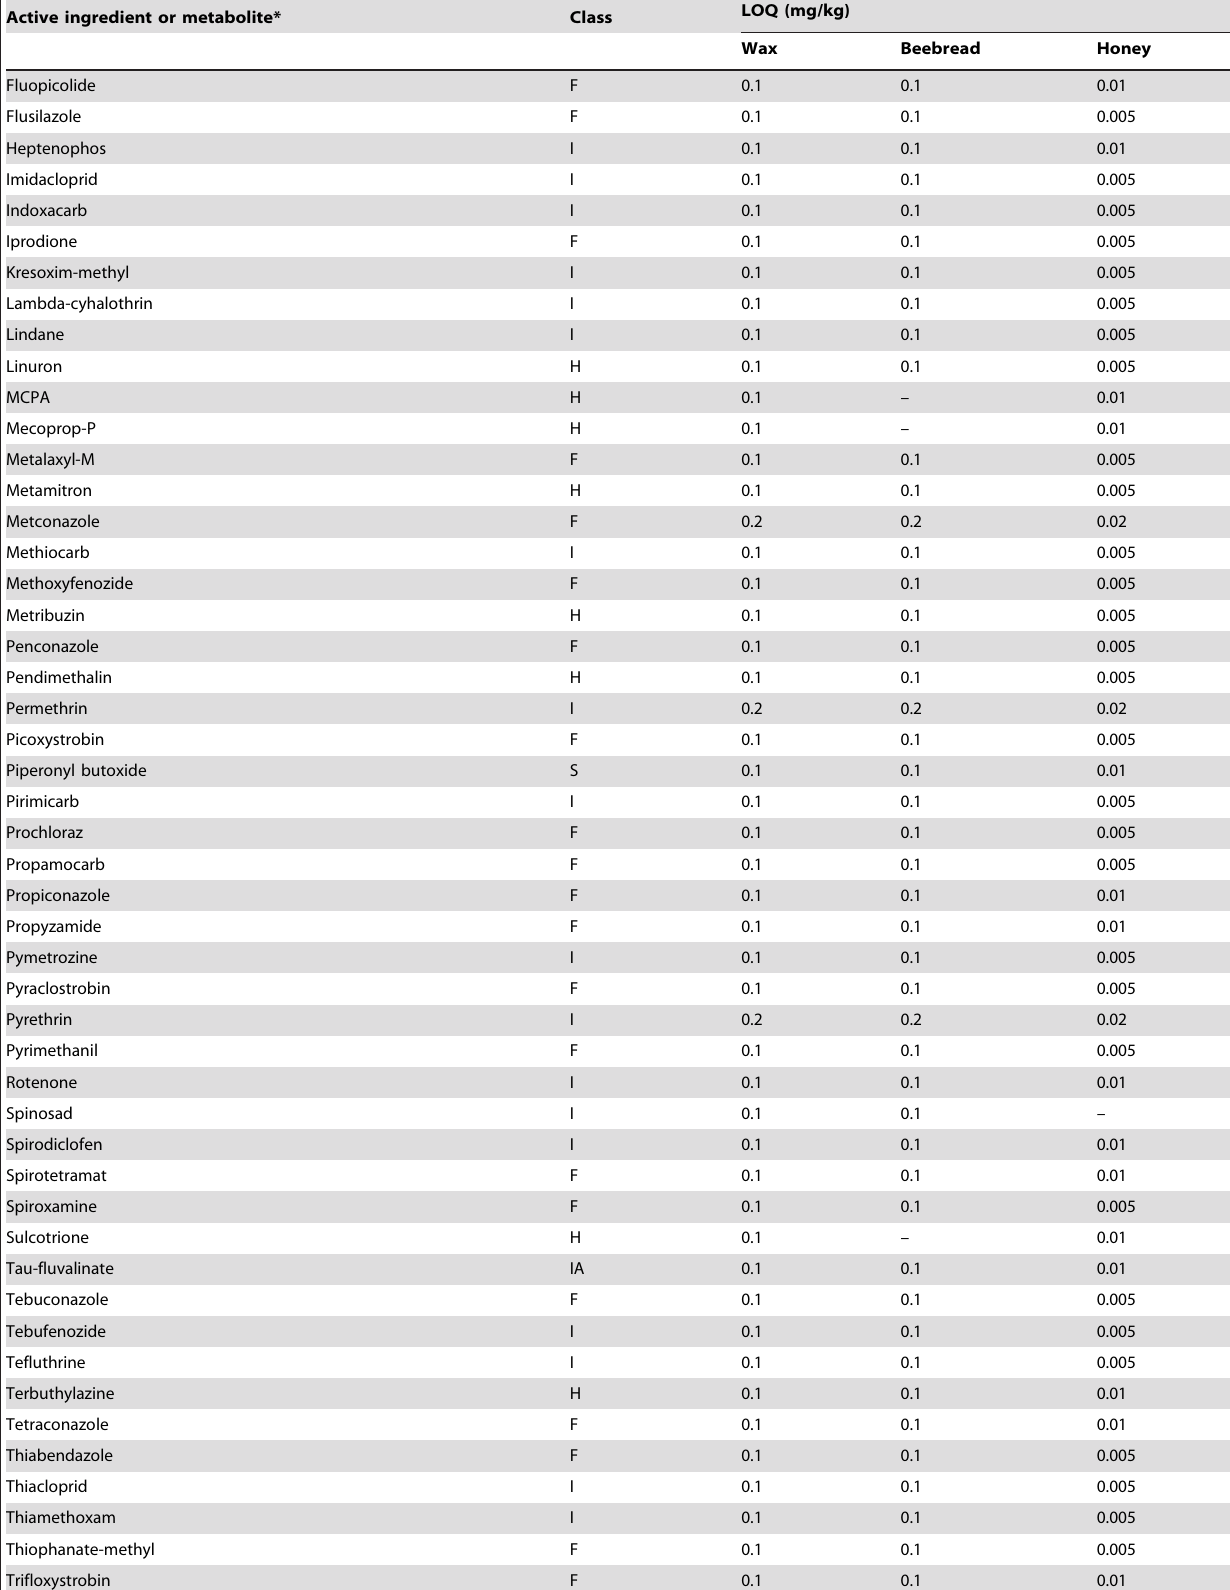
Active ingredient or